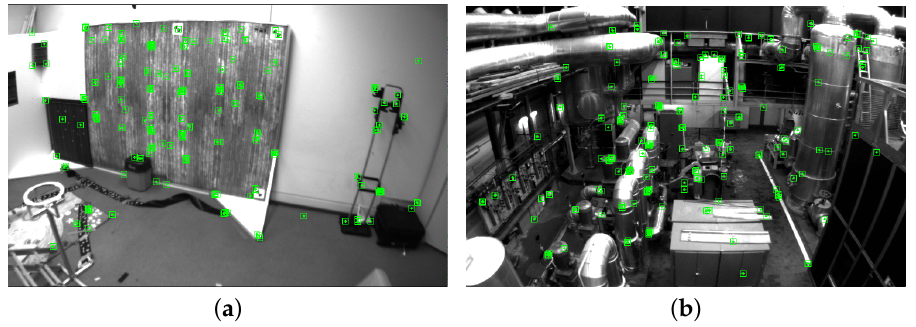
Figure 8. The representative images of two scenes: ( a ) the Vicon room and ( b ) the machine hall.